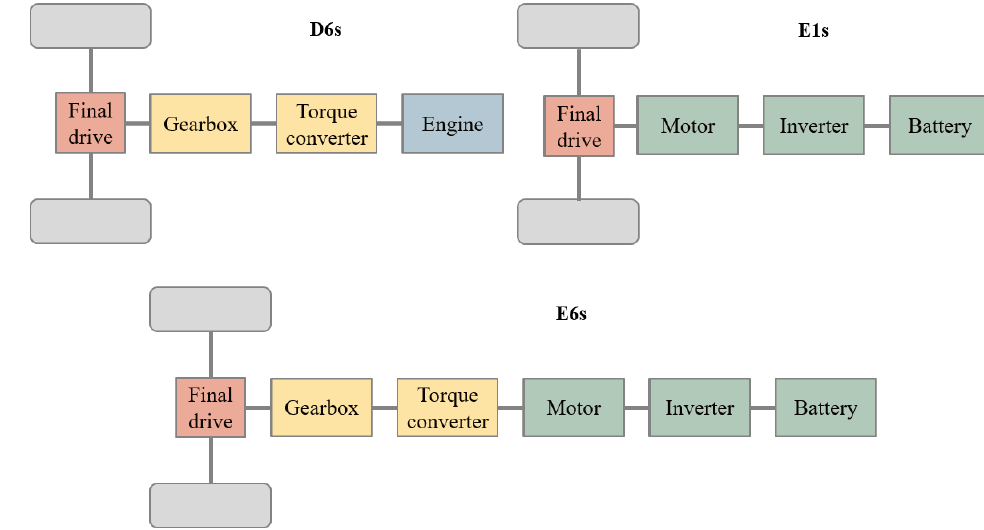
Figure 2. Three powertrain configurations used in the simulations.